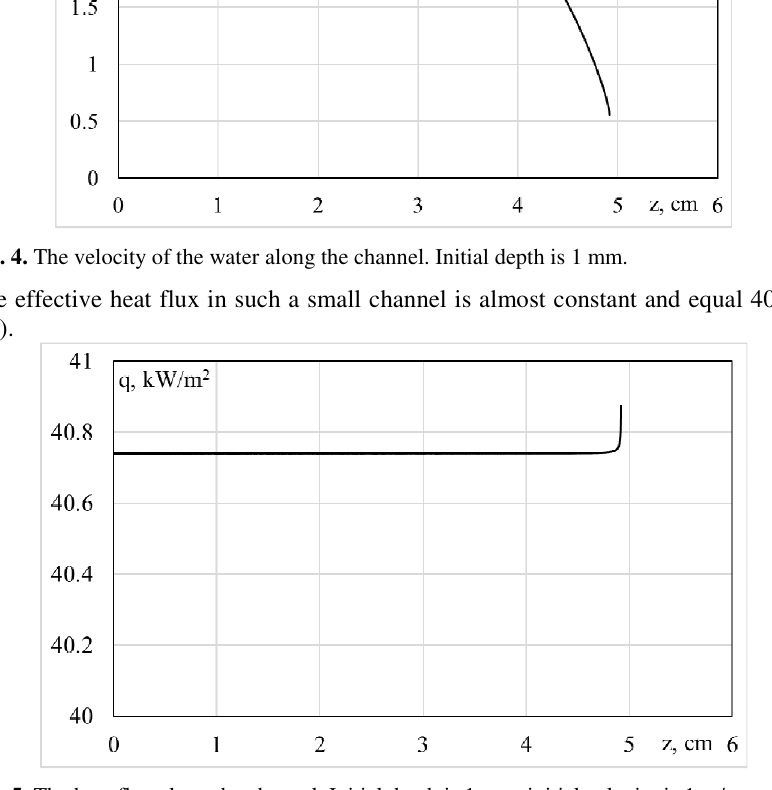
Fig. 5. The heat flux along the channel. Initial depth is 1 mm, initial velocity is 1